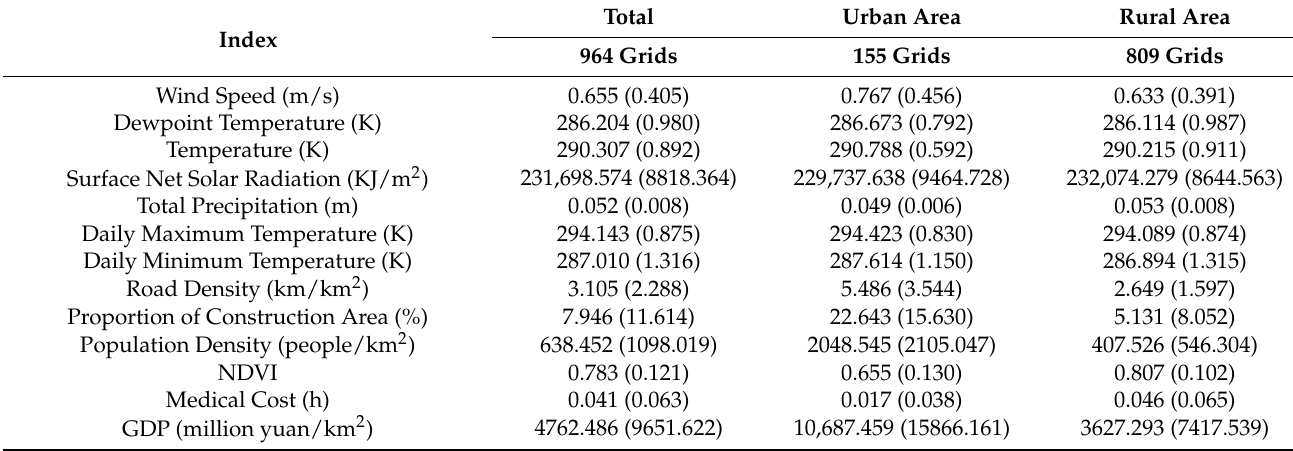
Table 2. Mean and standard deviations of urban and rural